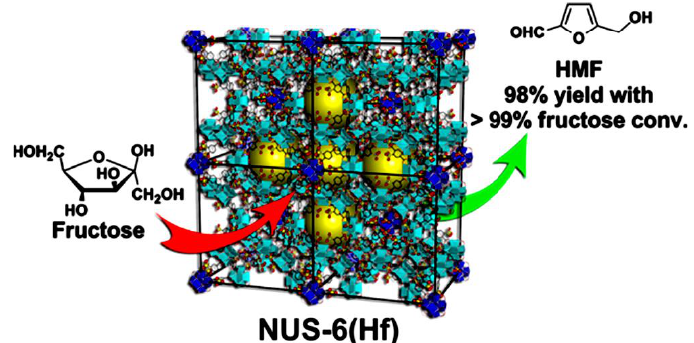
Figure 8. Synthesis of HMF from fructose over hierarchically porous NUS-6(Hf) catalyst. Reprinted with permission from reference [77]. Copyright 2016 American Chemical Society .